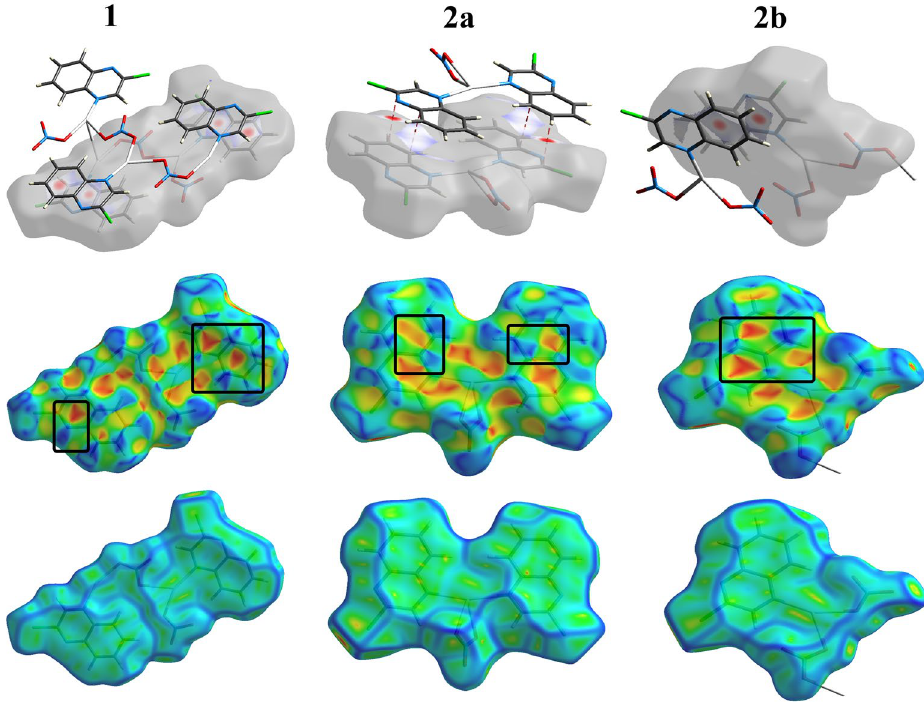
Figure 12. The d norm maps of C…C contact (upper), shape index (middle), and curvedness (lower) of three complexes.